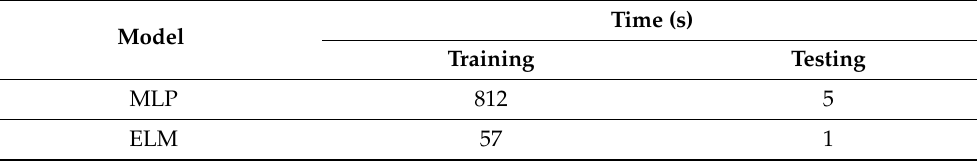
Table 6. Comparison of the time performance of both models on SCADA dataset.